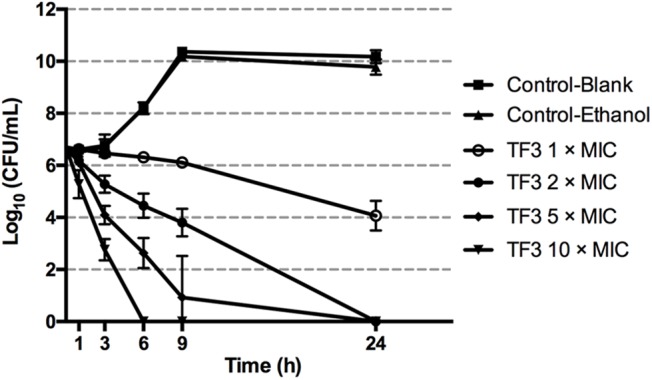
Killing curves of TF3 on Streptococcus mutans UA159 in CDM. The initial bacterial concentration was 5 × 106 CFU/mL. Concentrations of bacterial cells were determined by colony counting after treatment with TF3 at 1, 2, 5, and 10× MIC for 1, 3, 6, 9, and 24 h. The results are given as means and standard deviations from three independent experiments.